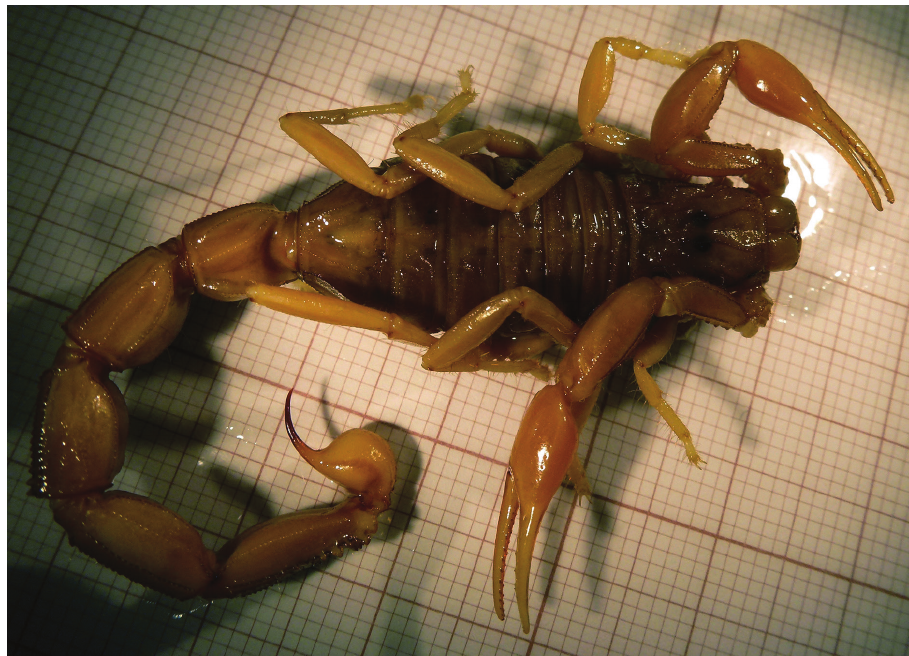
Figure 16. Photo of a B. parroti female syntype (MNHN Nº RS1870), from the Ademine Forest, 04- 1939, S.W. of Agadir, Morocco (Vachon